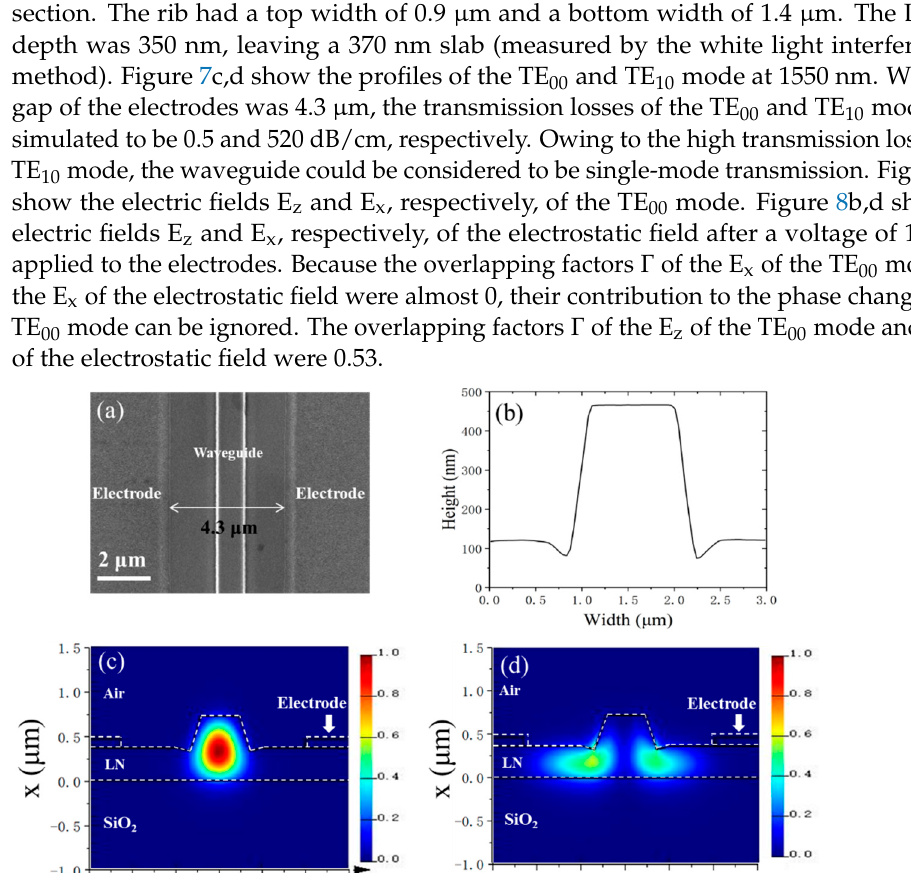
Figure 8. Electric field E z ( a ) and E x ( c ) distributions of the TE 00 mode. Electric field E z ( b ) and elec- tric field E x ( d ) distributions of the electrostatic field after 1 V voltage was applied to the elec- trodes. Figure 9a shows the variation of output light power with time after applying volt-ages of 5 and 0 V on the electrodes. When the voltage was 0 V, the output light power was stable with time; when the voltage was 5 V, the output light power varied significantly with time. The light power variation was related to the DC bias drift, which resulted from the flow and redistribution of electrical charge in the LN region under DC voltage [26]. This phenomenon would cause uncertainties in the measurement of V π . Triangular waves (200 kHz with an amplitude of 18 V) were used to minimize the in- fluence of the DC bias drift. Figure 9b shows the measured light transmission at 1550 nm. The red and black lines represent the triangular wave electrical and optical signals,